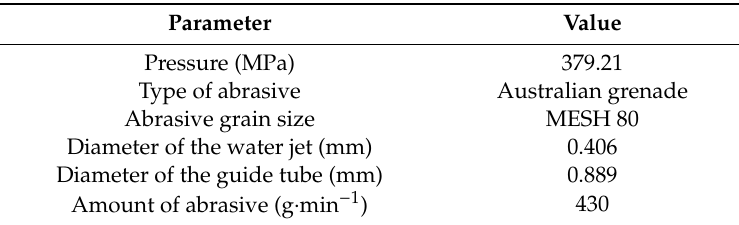
Table 3. Cutting parameters